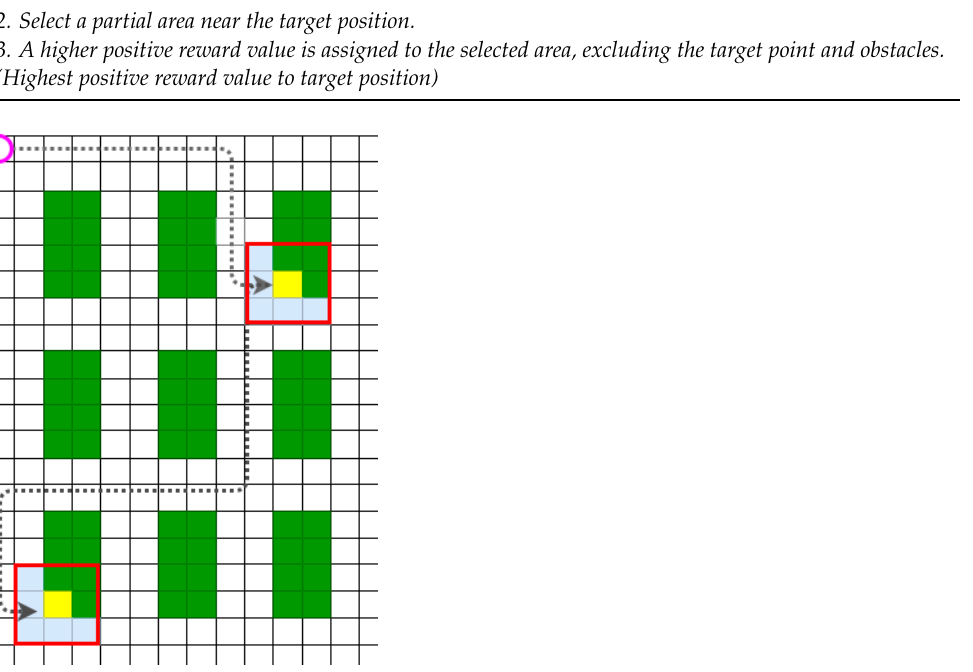
Figure 8. Dynamic adjusting reward values for the moving action.